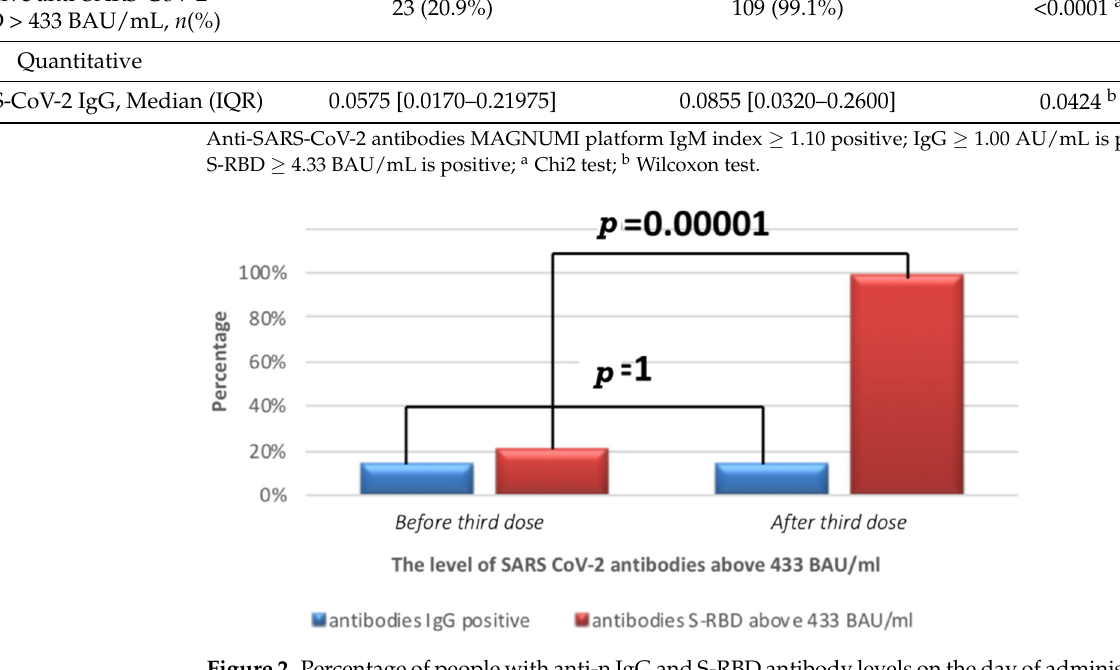
Figure 2. Percentage of people with anti-n IgG and S-RBD antibody levels on the day of administration of the third dose of anti-COVID-19 vaccine and 14 days after administration of the third dose of anti-COVID-19 vaccine.